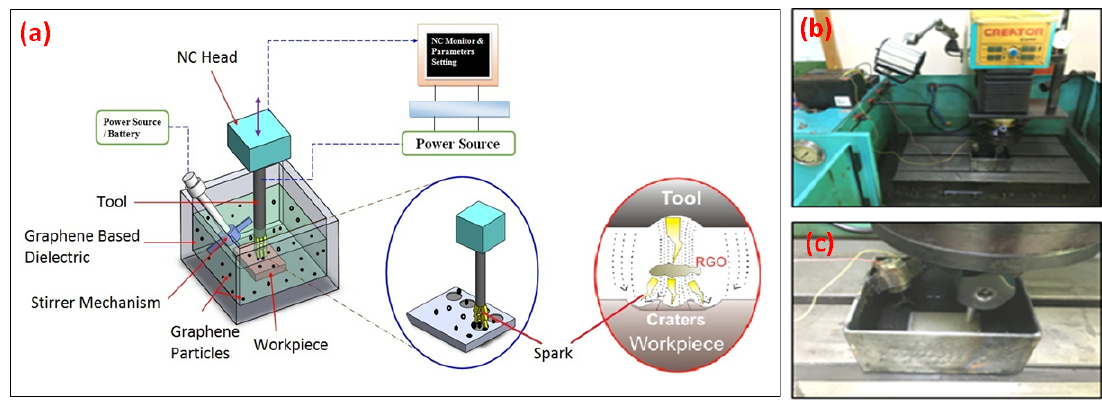
Figure 1. Setup of EDM Die Sinking: ( a ) 3D drawing of experimental setup; ( b ) actual machining setup; ( c ) workpiece setting in the container.